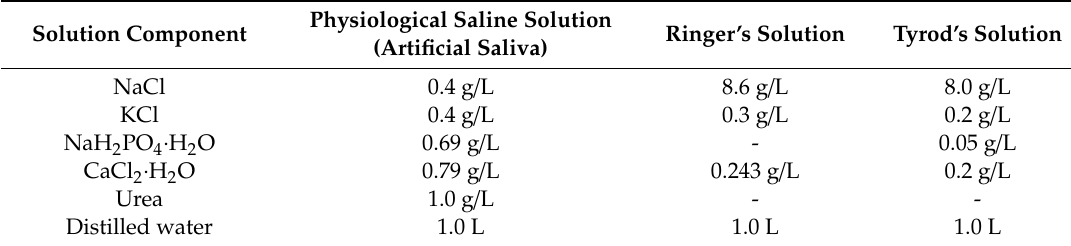
Table 4. Composition of solutions for corrosion resistance